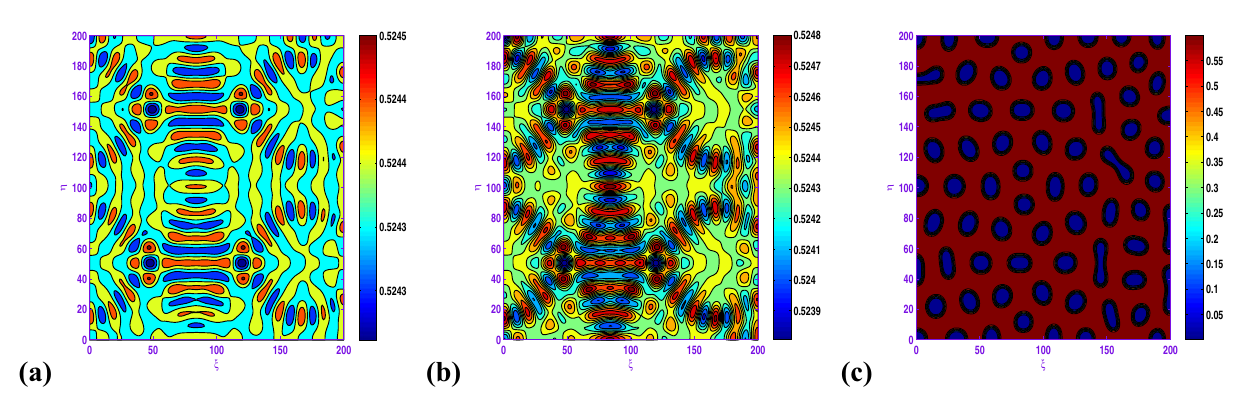
Figure 7. Transition of spatial dynamics of the prey population ( u ) in the model (9) , for the set a = 0.5 , b = 0.9 , β = 1.0 , d = 0.3 , l = 0.01 , d